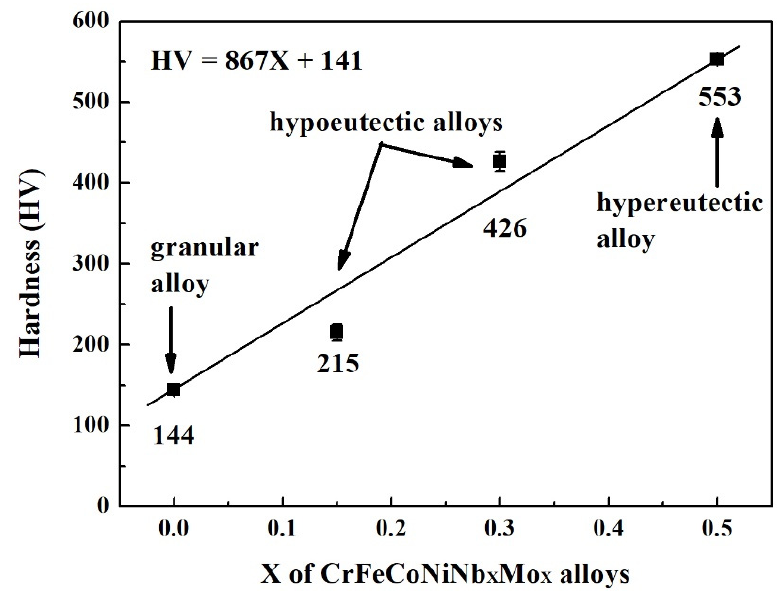
Figure 3. Hardness of as-cast CrFeCoNiNb x Mo x alloys. Each value is the average hardness of the alloy. Figure 4 shows the potentiodynamic polarization curves of the as-cast CrFeCoNiNb Mo x x alloys in 1M deaerated H 2 SO 4 solution at 30 °C. The potentiodynamic